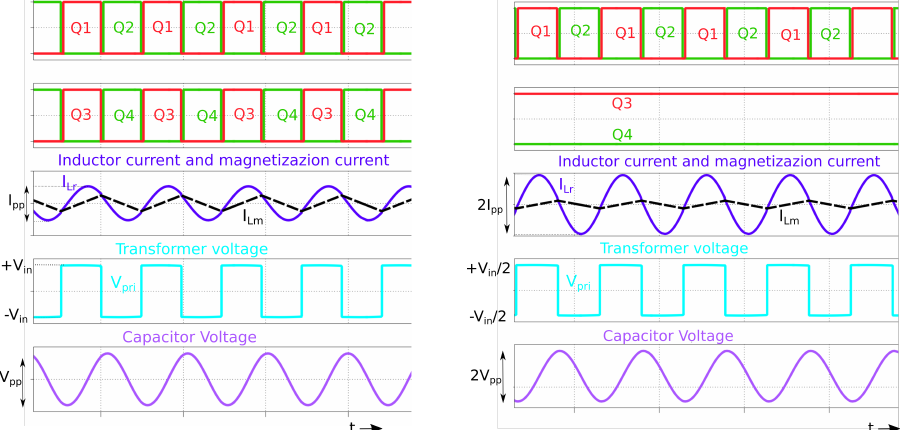
Figure 6. Wave-form for ( left ) fault-free operation ( right ) under-fault